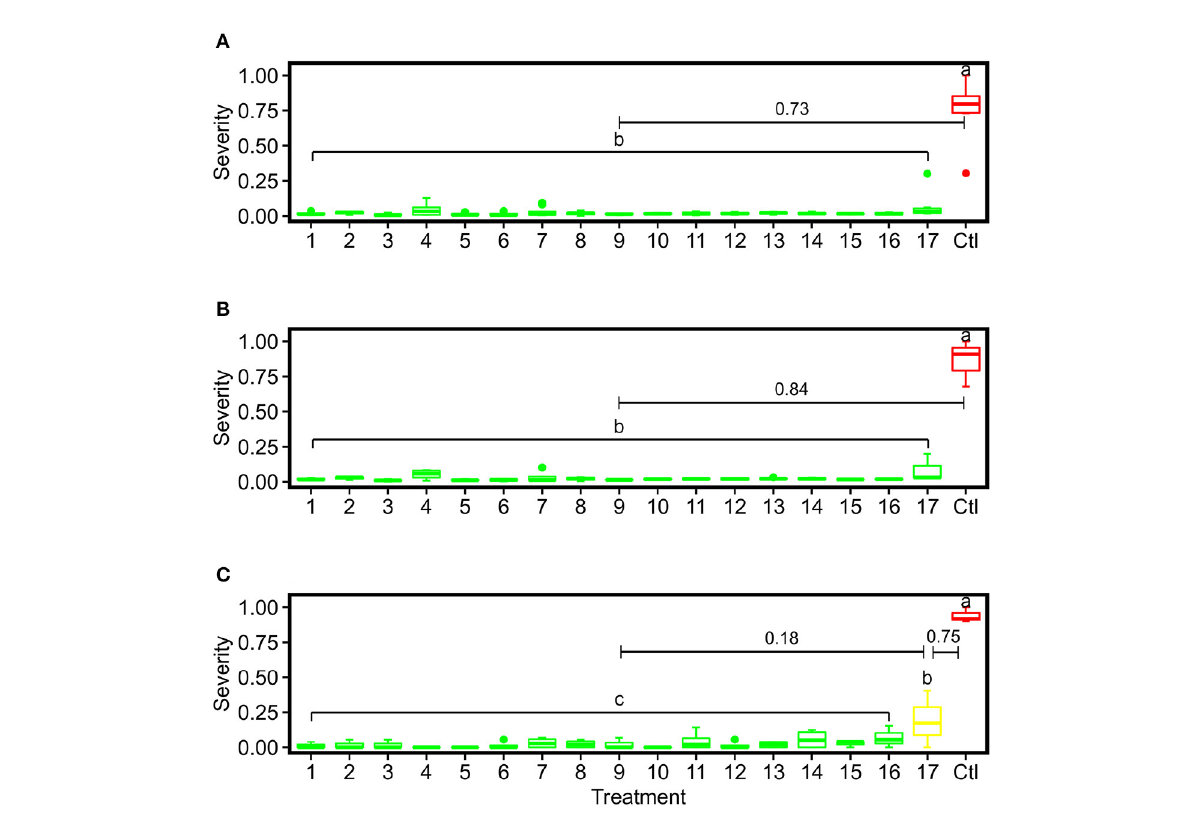
FIGURE13 Box plots of severity rates for the 17 treatments together with the control group for PM fungicide efficacy test in this study: (A) represents the imaging-derived severity rates at the panel level, (B) represents the imaging-derived severity rates at the spray unit level, and (C) represents the severity rates evaluated by human experts. Different letters indicate statistical significance between groups. Treatments within the same group are assigned the same color. The numbers with bars indicate differences of mean values between adjacent severity